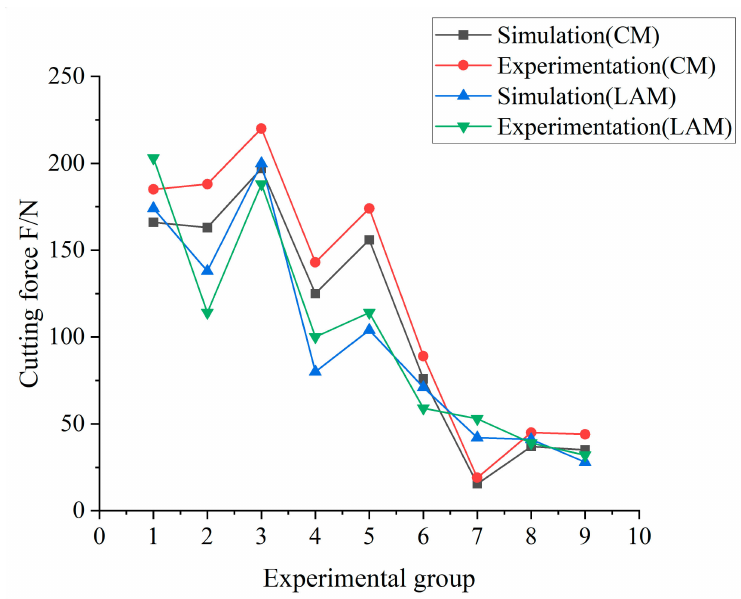
Figure 3. Comparison of simulated and experimental cutting forces.